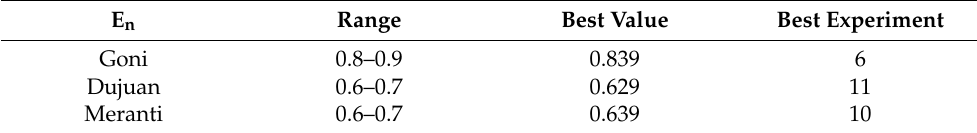
Table 15. E n statistics of the significant wave height simulation in the three typhoon events.